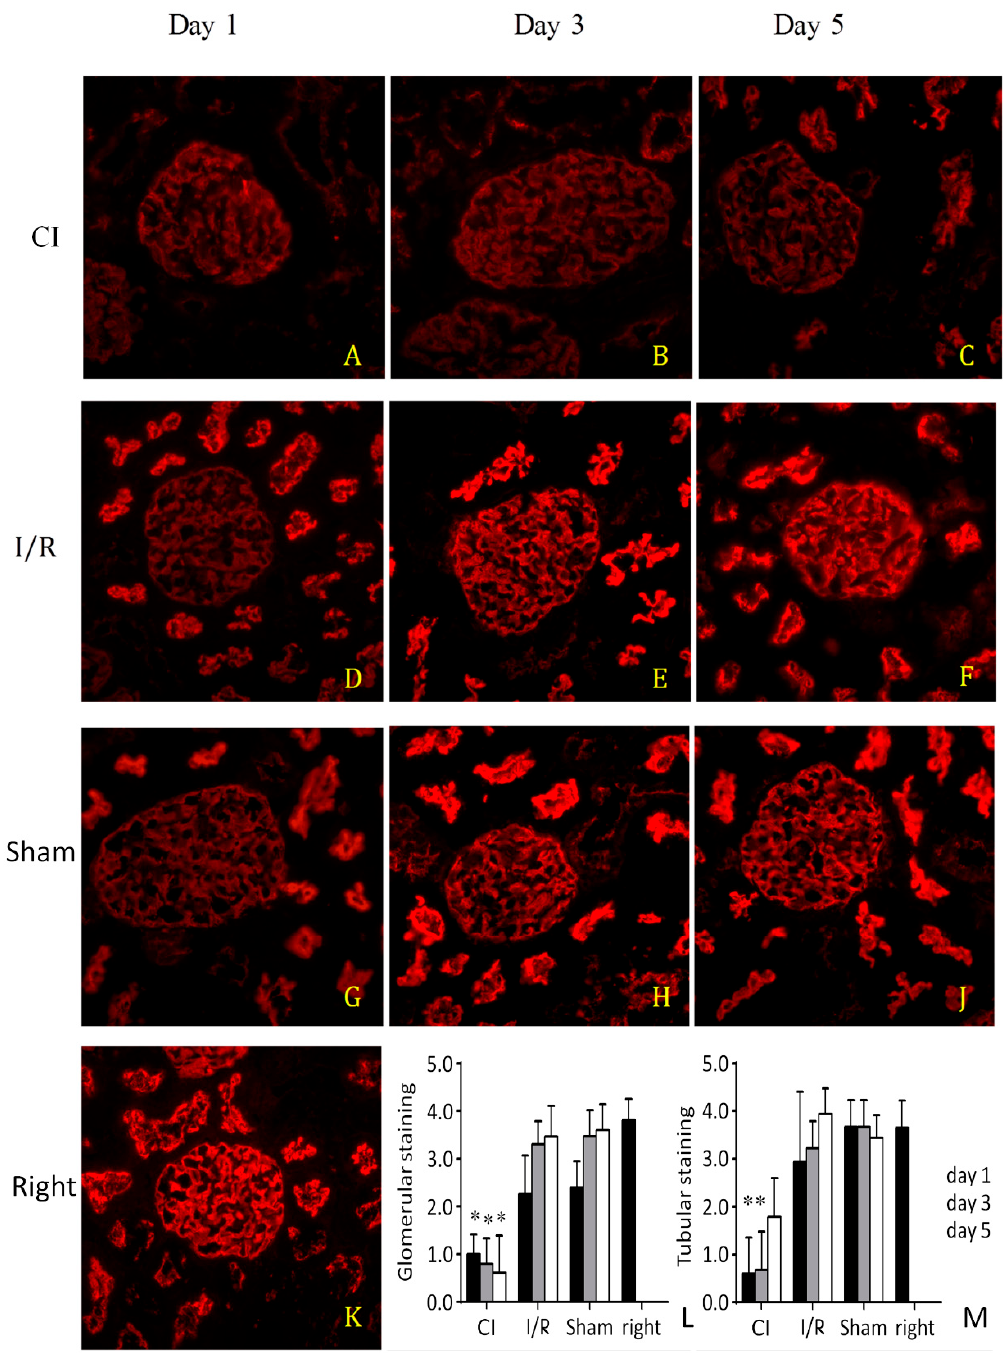
Figure 4. Indirect immunofluorescence for ezrin. Representative images of operated left kidneys, one ( A , D , G ), three ( B , E , H ), and five ( C , F , J ) days after surgery. First row ( A , B , C ): cold ischemia (CI). Second row ( D , E , F ): ischemia ‐ reperfusion (I/R). Third row ( G , H , J ): sham. Fourth row: unoperated right kidney from a sham animal ( K ), (400×). Quantitation of glomerular ( L ) and tubular ( M ) ezrin staining intensity (score: 0–4, 0: no, 1: faint, 4: intense, sharp staining). *: p < 0.05 vs. corresponding sham (n = 8 in all groups).